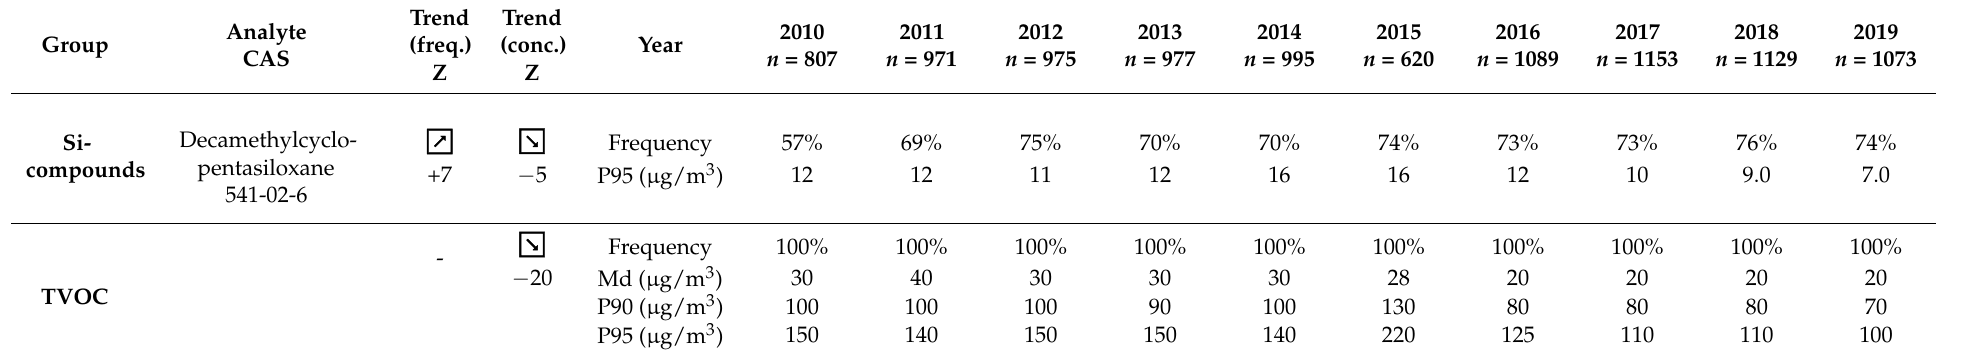
Table 4. Annual statistics of VOCs (a) and formaldehyde (b) during the ten-year study period 2010–2019. Frequency trend was tested using Somer’s D test, where input data were binomial (measurement result either >LOQ or <LOQ). Concentration trend was tested using Somer’s D test, where input data comprised all measured concentration values. Here, measurement results that were <LOQ were replaced by a concentration value LOQ/2. Trends indicated by downward or upward arrow symbol were statistically significant ( p < 0.0001) and had ǀ Z ǀ ≥ 4. Z values shown below arrow symbols indicate direction and steepness of trend.